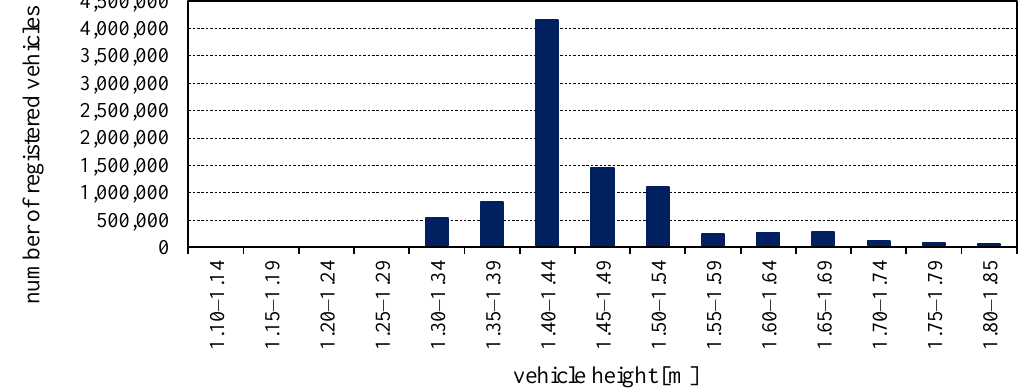
Figure 5. Absolute frequency distribution of passenger cars heights.